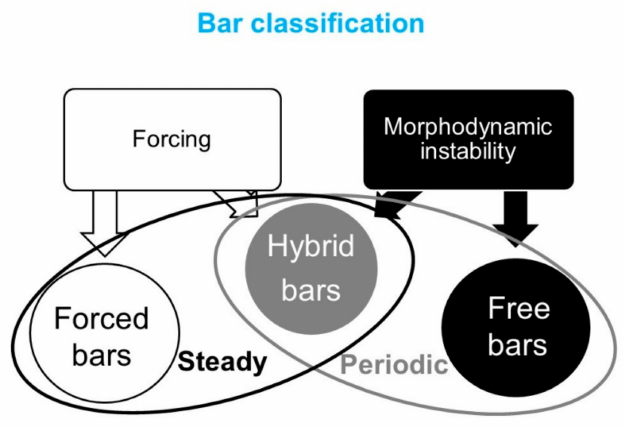
Figure 4. Bar classification after Dur ó et al.